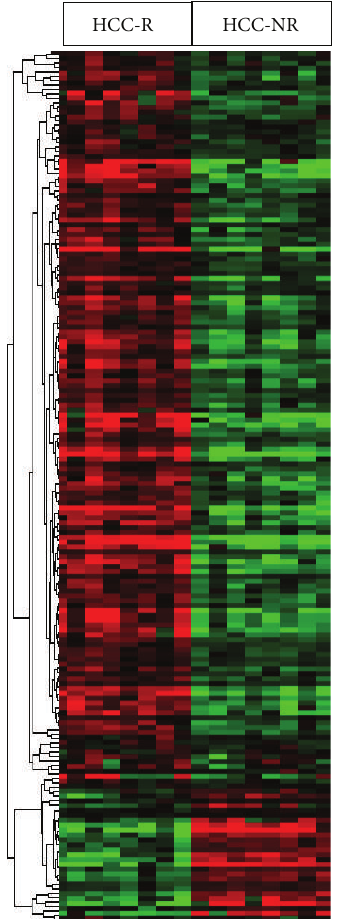
Figure 3: Hierarchical clustering for 194 genes differentially ex- pressed in HCC-R (FDR corrected ≤ 0.05). For visual comparison, genes differentially expressed in HCC-R and HCC-NR were clus- tered by the TreeView program. The red color represents genes upregulated, and the green color represents genes downregulated. Saturation was set at ± 2-fold